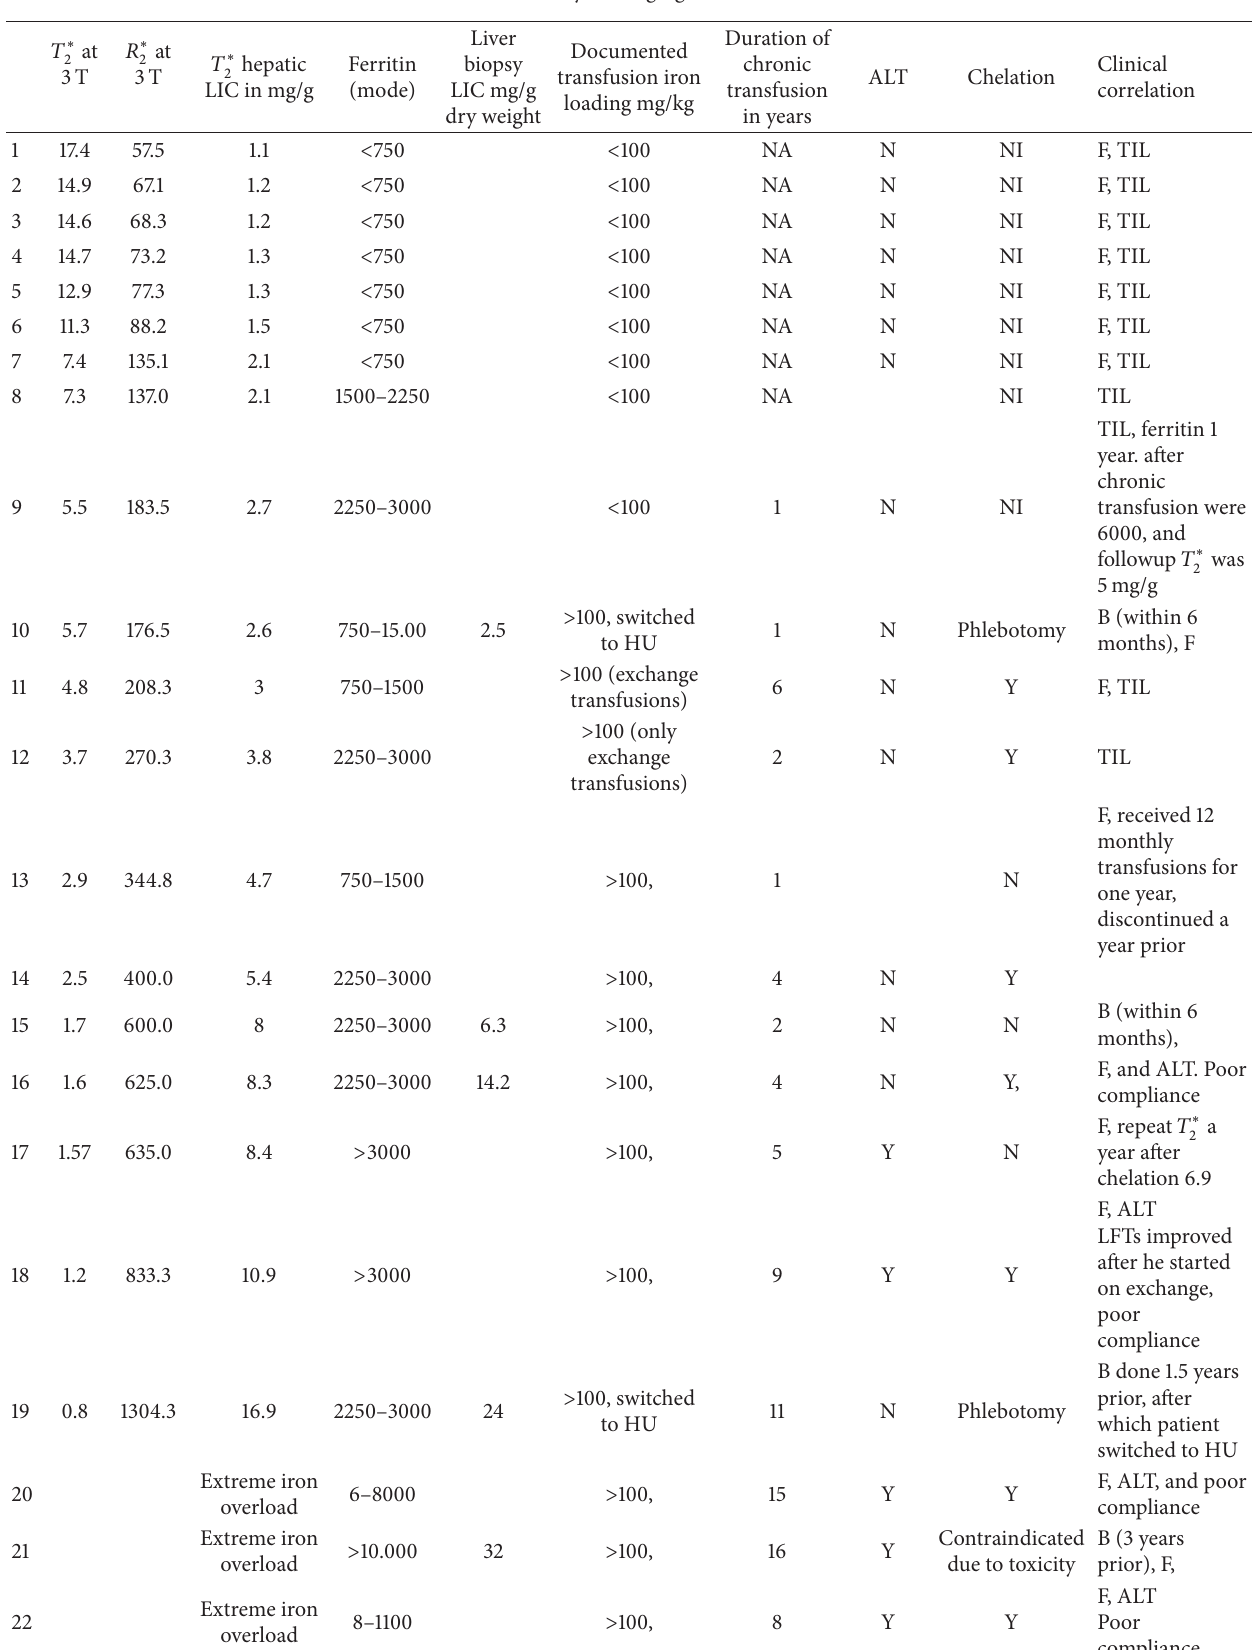
Table 1: Summary of imaging and clinical